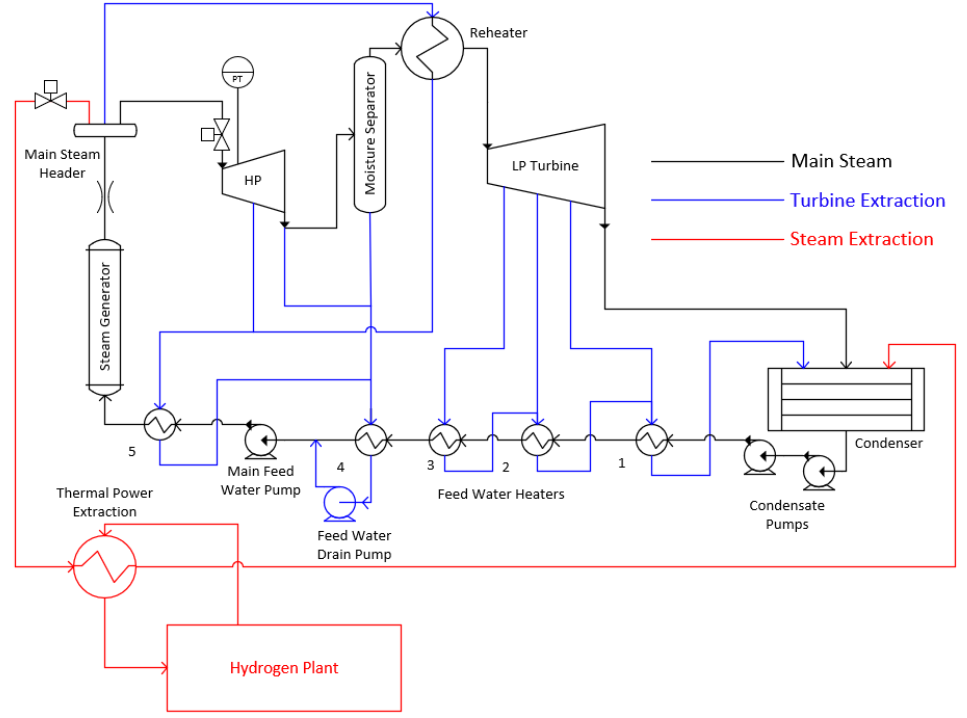
Figure 1. Generic layout for thermal power extraction from a PWR.